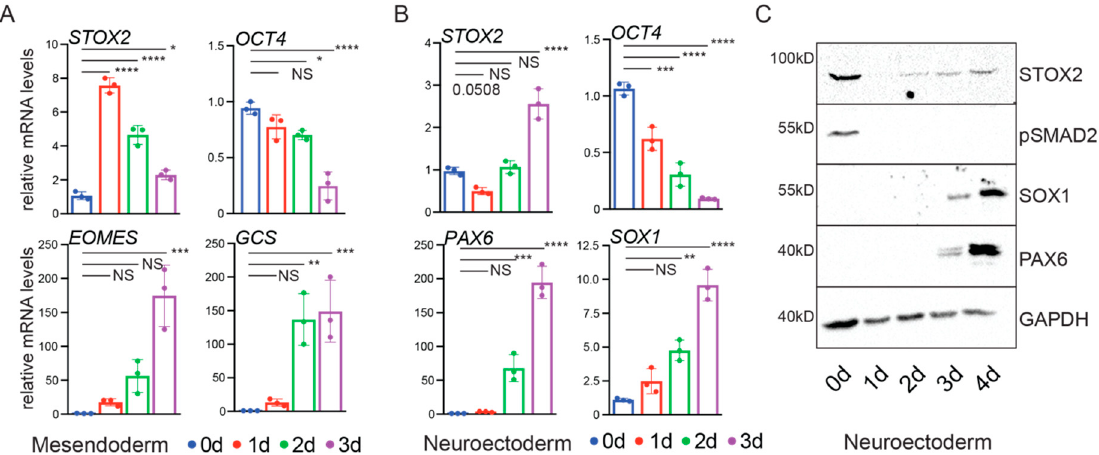
Figure 6. STOX2 is differentially expressed upon cell fate specification of hESCs. Relative STOX2 mRNA levels during mesendoderm ( A ) and neurectoderm ( B ) specification. Indicative transcripts for mesendoderm (EOMES) and (Gooscoid, GCS) ( A ) or neurectoderm (PAX6) and (SOX1) ( B ) were used as readout for effectiveness of the differentiation process. Relative expression levels were calculated by the ΔΔ Ct method relative to GAPDH and HPRT (N = 3, average ± SD, p -value * p < 0.05, ** p < 0.01, *** p < 0.001, **** p < 0.0001, ordinary 1-Way ANOVA, Dunnett’s multiple comparisons). ( C ) Immunoblot analysis of STOX2 protein levels during differentiation of hESCs towards neurectoderm. Protein levels of PAX6 and SOX1 are used to indicate the success of the differentiation and levels of pSMAD2 to monitor the block of TGF- β signaling. Equal loading was ensured by staining the membranes with antibodies against GAPDH. Representative images for three independent experiments are shown.